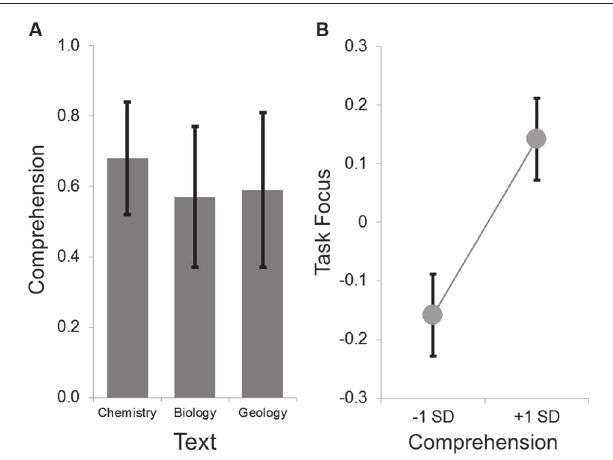
FIGURE 1 | Group level behavioral results. The group average for the comprehension ranged from .5 to .7 across the three texts, indicating that the measure was not a floor nor at ceiling. This is summarized in Panel (A) . LMMs comparing the within participant variation in comprehension and task focus indicated that on texts when comprehension was higher, participants reported better task focus. This is summarized in Panel (B) in which the parameter estimates extracted from the LMMs were used to estimate the task focus at one standard deviation above and below the mean. In both panels the error bars indicate the standard error of the